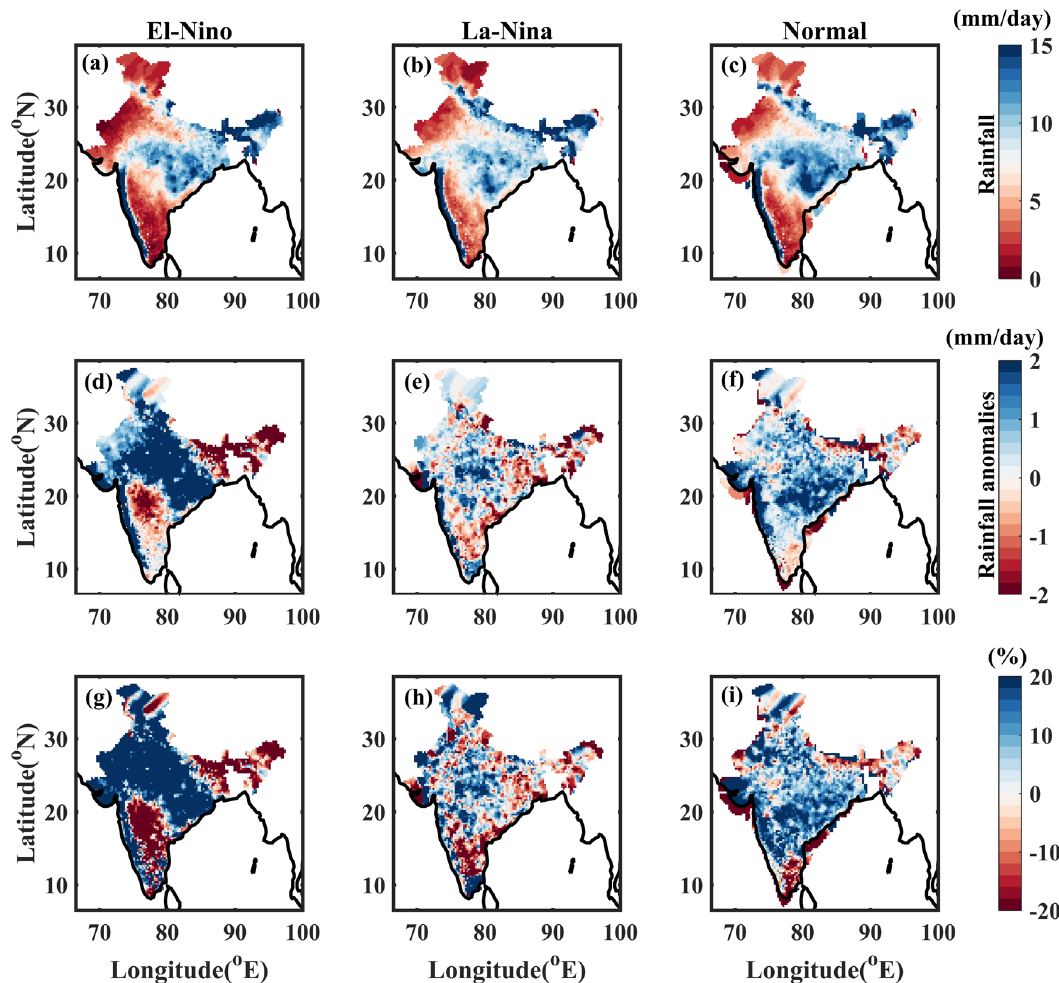
Fig. 4 Rainfall over India during El-Nino, La-Nina and Normal years. a – c climatological rainfall (mm day-1) pattern, d – f rainfall anomalies, g – i rainfall anomalies expressed in terms of